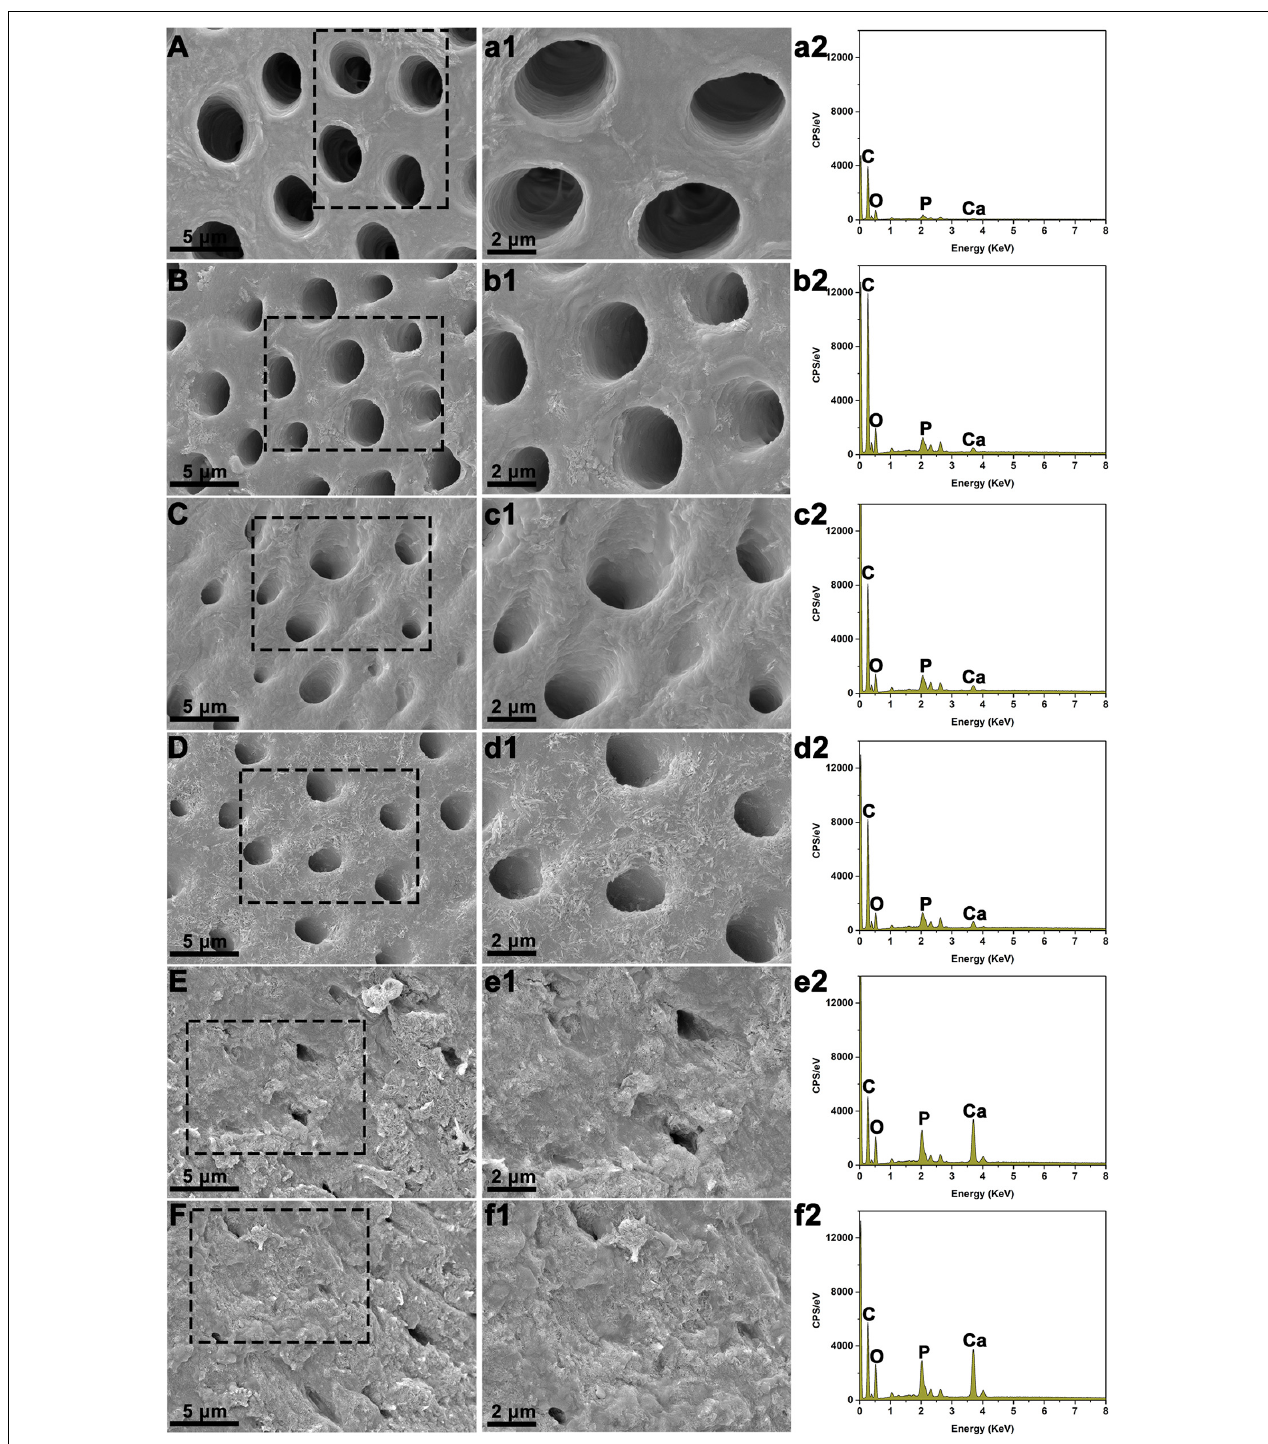
FIGURE 9 | Scanning electron microscopy (SEM) with energy-dispersive X-ray spectroscopy (EDS) analysis of dentin surface morphology following immersion with various BAG-modified composite resins in SBF for 21 days. (A,a1,a2) The dentin disks with demineralized treatment immediately. (B,b1,b2) The demineralized dentin disks immersed in the blank SBF for 21 days. (C,c1,c2) The demineralized dentin disks immersed with BAG0 in the SBF for 21 days. (D,d1,d2) The demineralized dentin disks immersed with BAG8 in the SBF for 21 days. (E,e1,e2) The demineralized dentin disks immersed with BAG16 in the SBF for 21 days. (F,f1,f2) The demineralized dentin disks immersed with BAG23 in the SBF for 21 days. (A-F) SEM images (scale bar: 5 µ m); (a1–f1) Higher magnification of the black box area in panels (A–F) (scale bar: 2 µ m); (a2–f2) EDS analysis. BAG0 indicates composite resin without BAG; BAG8 indicates composite resin with 8 wt% BAG; BAG16 indicates composite resin with 16 wt% BAG; BAG23 indicates composite resin with 23 wt% BAG.